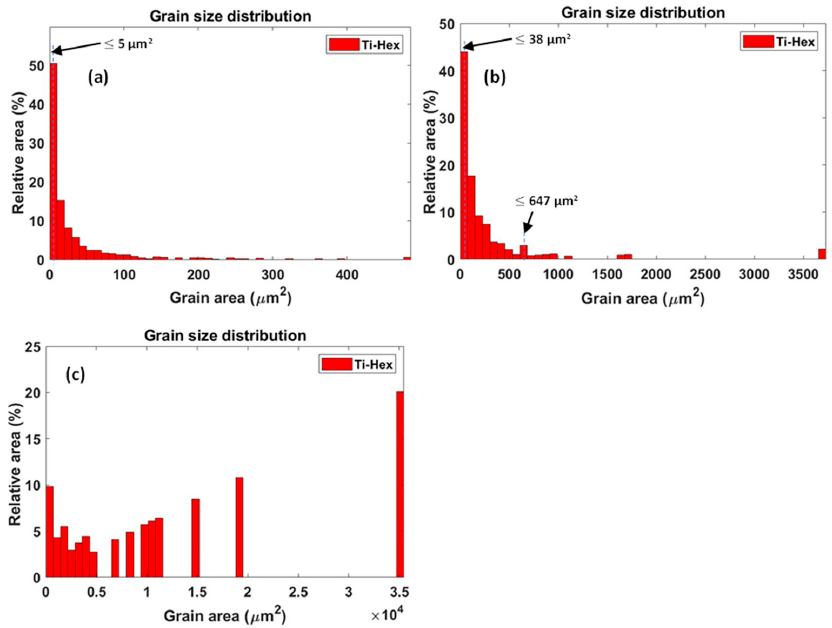
Figure 6. The area fraction distribution of different grain sizes determined from EBSD maps of ( a ) samples C, ( b ) samples D and ( c ) samples E.